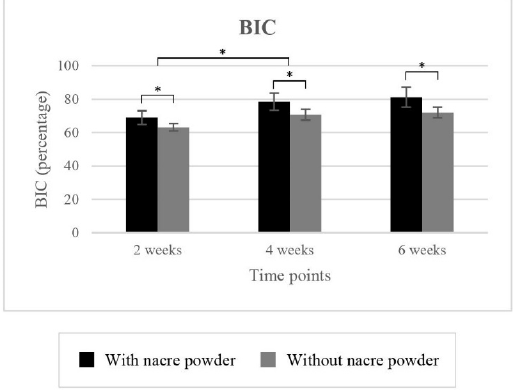
Figure 2. The clustered columns showing mean BIC in percentage of implantations with or without nacre powder using XiVE ® dental implants. * indicates difference at significance level 0.05.